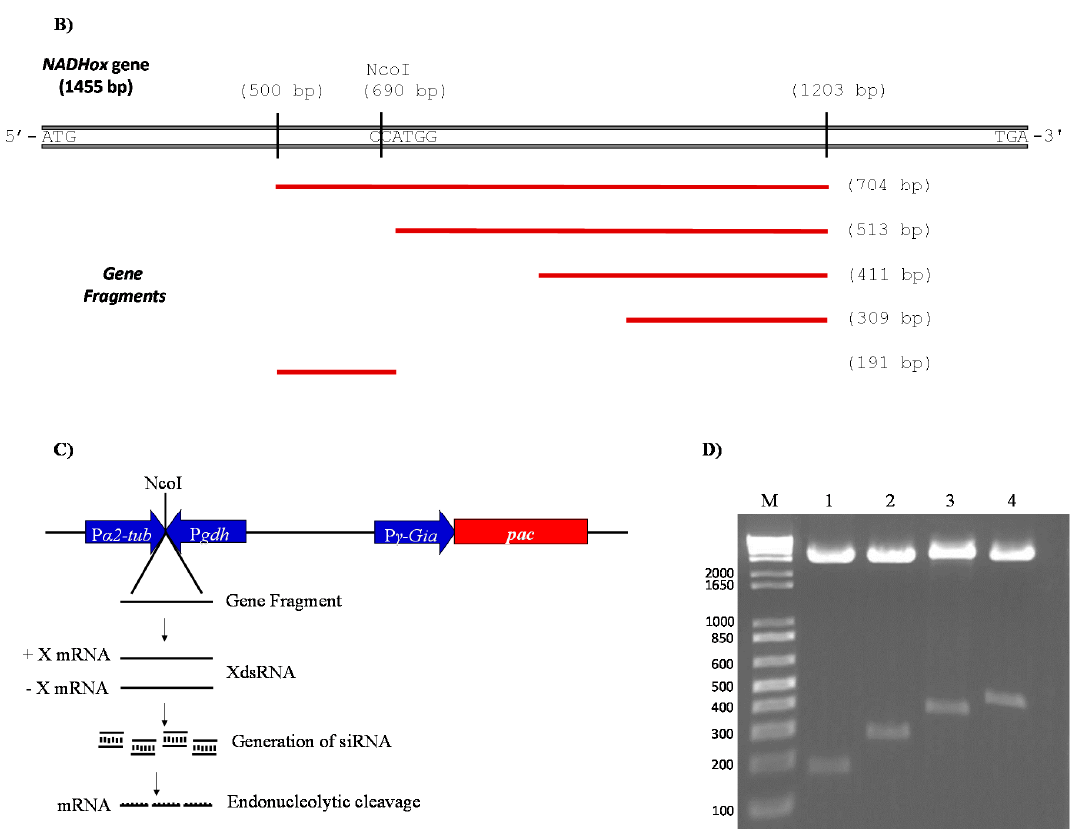
Figure 1. Vectors and strategy to generate double-stranded RNAs (dsRNAs) from the NADHox gene. ( A ) Map of the p TubGdh -RNAi and p TubGdh _eGFP-RNAi vectors, showing the position of the α 2-Tub :: gdh cassette with the Nco I cloning site. The pac gene, conferring resistance to puromycin,